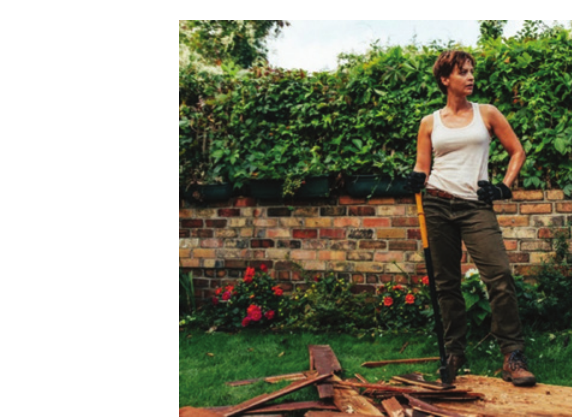
figure 4: Julie cox as clare, behind the scenes of Lost Property (photograph: clement